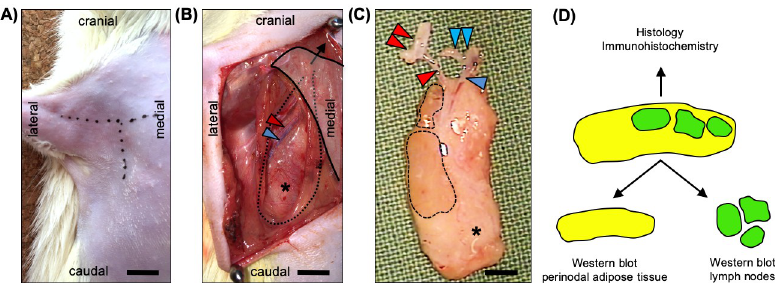
Fig 1. The axillary VLN flap model. A T-shaped skin incision in the right axilla. B The pectoralis major muscle is retracted cranio-medially (black arrow) and the lateral thoracic artery (red arrowhead) and vein (blue arrowhead) are identified. Dotted line and asterisk = VLN flap. C Completely dissected VLN flap containing lymph nodes (broken lines) and perinodal adipose tissue (asterisk). Vascular pedicle with lateral thoracic artery (red arrowhead), axillary artery (double red arrowhead), lateral thoracic vein (blue arrowhead), and axillary vein (double blue arrowhead). D Separation of lymph nodes and perinodal adipose tissue for Western blot analyses. Scale bars: A and B = 6 mm, C = 3 mm. VLN = vascularized lymph